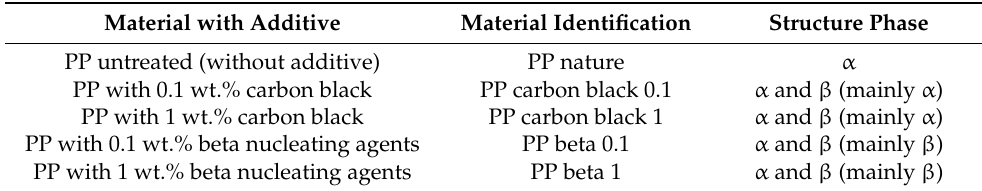
Table 1. List of materials used for